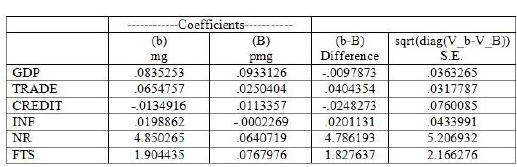
Table 7: Hausman Test